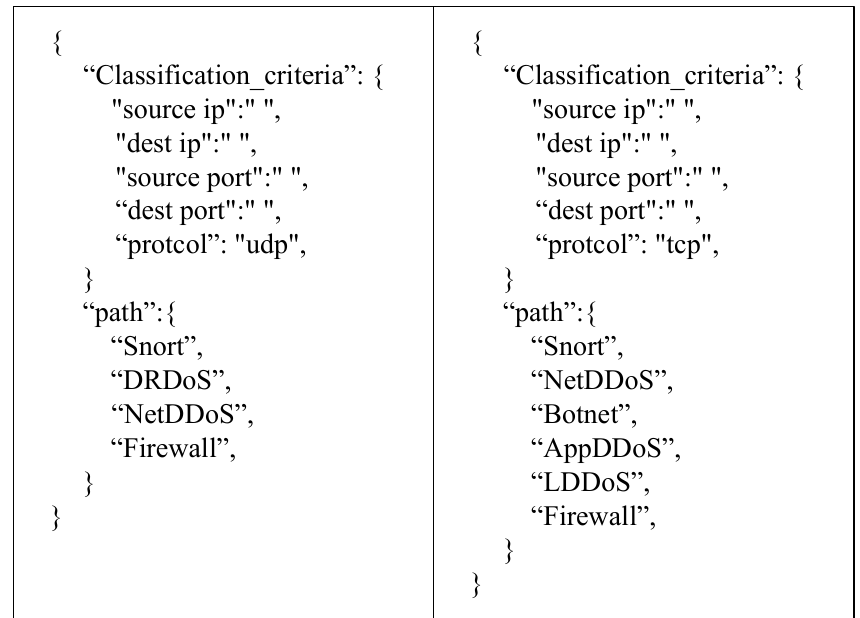
Figure 11. Path policies under UDP and TCP.